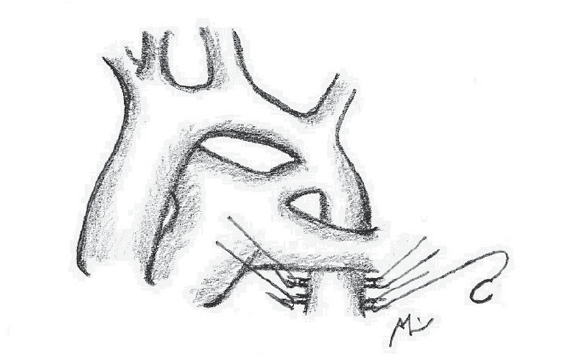
Fig. 3 - Ligadura das artérias intercostais